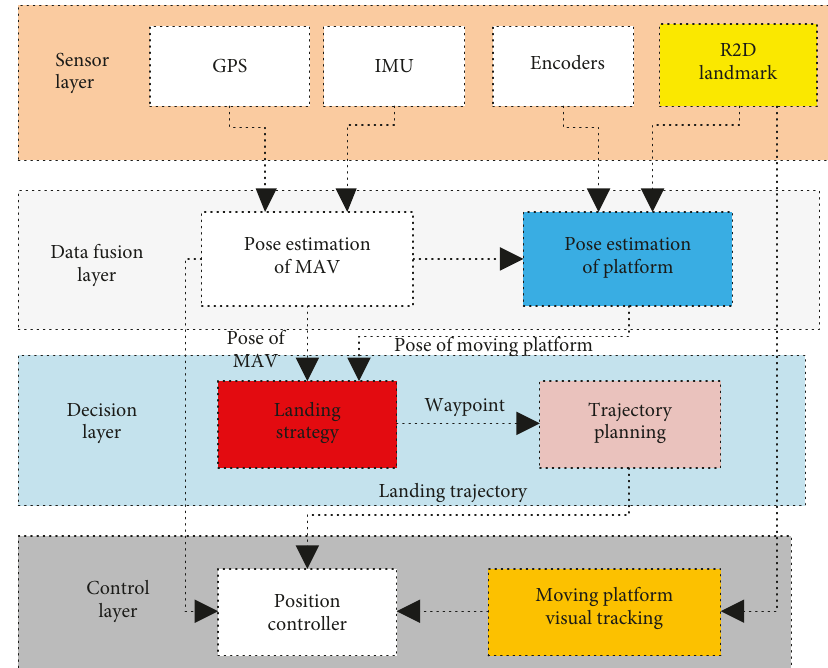
Figure 1: Flow chart of the R2D-MPL